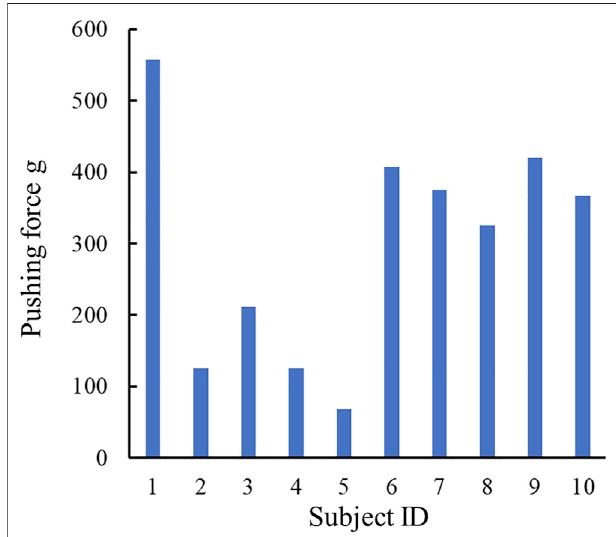
FIGURE8| Individual difference ofthepushingforce ofthemiddle fi nger when EMS parameters were as follows: pulse width: 200 µs, frequency: 40 Hz, and current value: 20 mA.